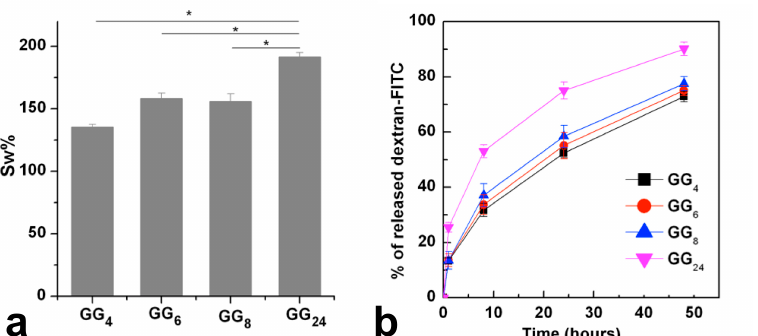
Figure 6. Swelling % of ionotropic crosslinked low molecular weight GG hydrogels incubated for 24 h in DPBS pH 7.4 at 37 °C ( a ), release of dextran- FITC from hydrogels ( b )